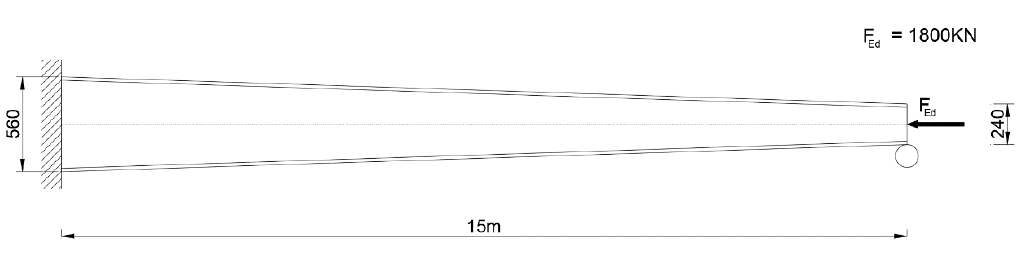
Figure 8. Example 3: description taken from [9,10] and [7] Section 5.2.